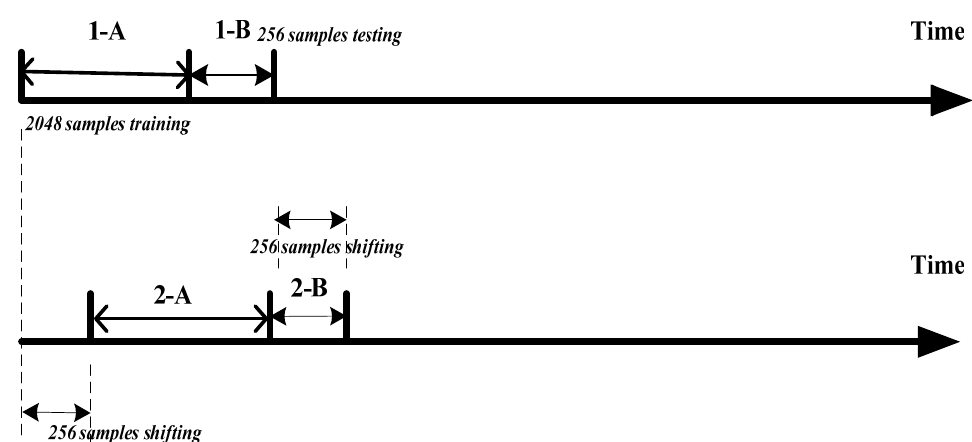
Figure 2. Rolling window method for training and forecasting ( n -A means the n th training period and n -B means the n th testing